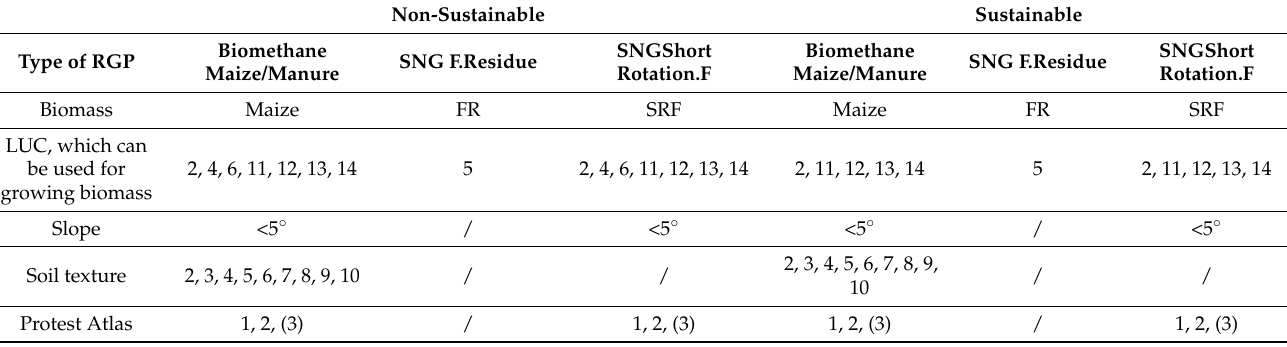
Table 3. Selected pixels from the land use map which can be suitable for maize and for the short rotation forestry production in the sustainable scenario are 2, 11, 12, 13, 14. While for the collection of forest residues, only land use type 5, which is the natural green area, is